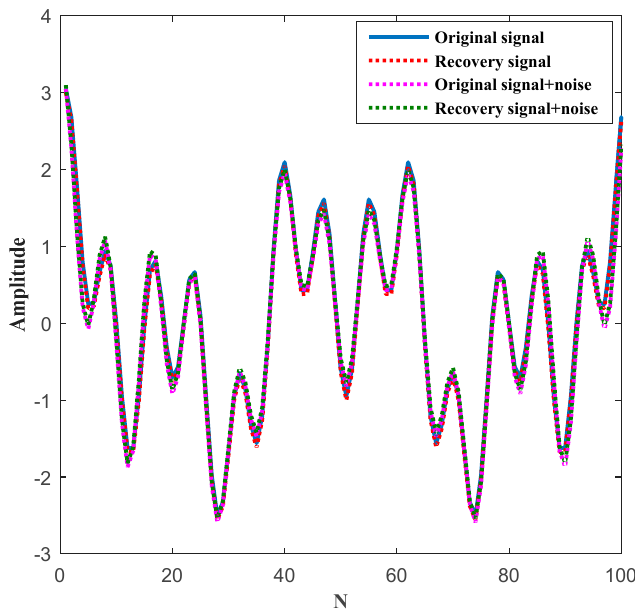
Figure 13. The influence of noise on theoriginal signal and recovery signal.